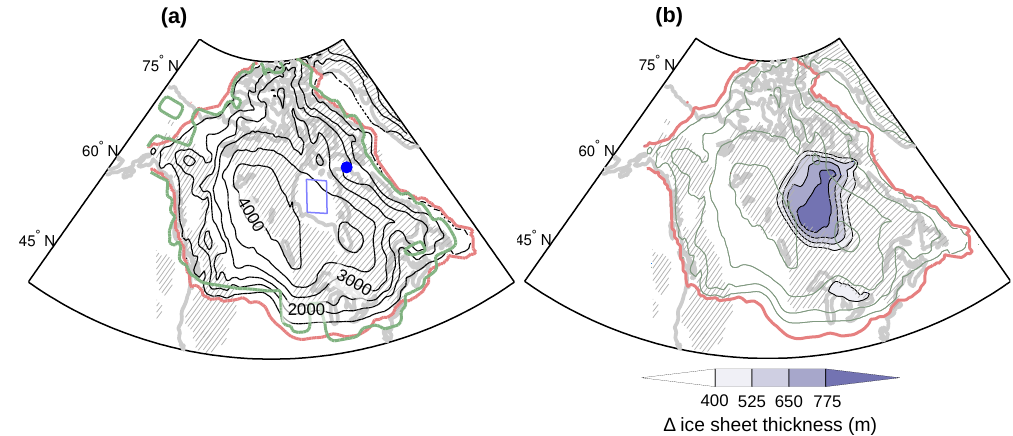
Figure 2. The mean height of the ice sheet (a) and the mean change in topography over a composite Heinrich event (b) . In (a) the black contours show the height of the ice sheet; contour interval 500m. The red contour shows the extent of the ice sheet as modelled by Glimmer; the green contour shows the extent of the ice5g ice sheet (Peltier, 2004). Hatched areas indicate areas of hard bed, where the sliding parameter is very low; the remaining areas are soft bed with higher sliding parameter. The blue square is the region over which the upper curve in Fig. 3 is averaged. The blue dot shows the location from which the time series in Fig. 5 are derived. In (b) we show the composite difference between the ice sheet thickness before and after an HE. The composite is the average over all HEs that occur during the 100kyr run of the model shown in Fig. 3.